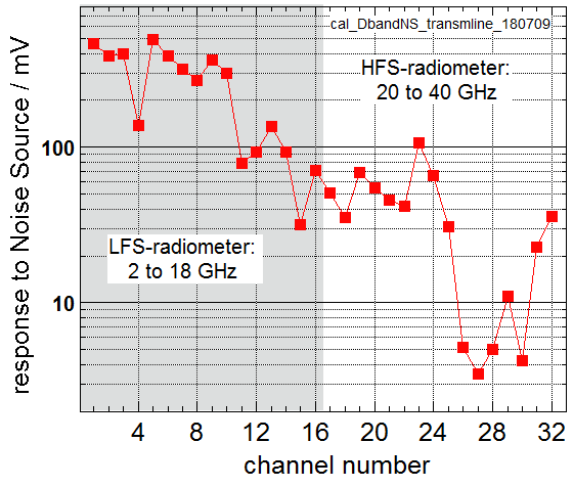
Fig. 6 : Individual response of the radiometer channels to the chopped Noise